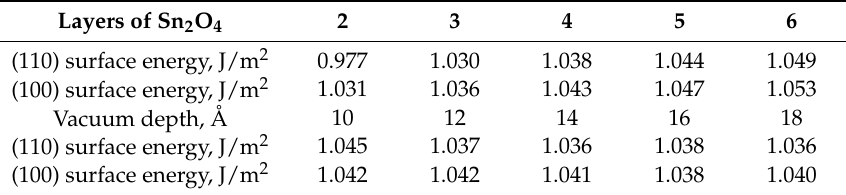
Table 5. (110) and (100) surface energy tests results as functions of slab thickness and vacuum depth.